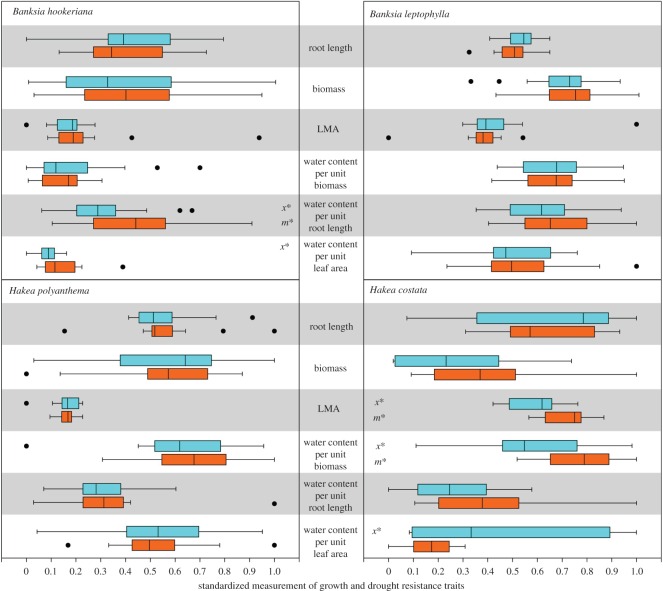
Standardized measurement of growth and drought traits of seedlings derived from HiR (blue) and LoR (orange) populations in the glasshouse experiment with full water supply. Box indicates 25–75th percentile, black dots represent outliers. An ‘x’ with an asterisk indicates a significant difference in mean values, and an ‘m’ with an asterisk indicates a significant difference in median values between HiR and LoR populations.